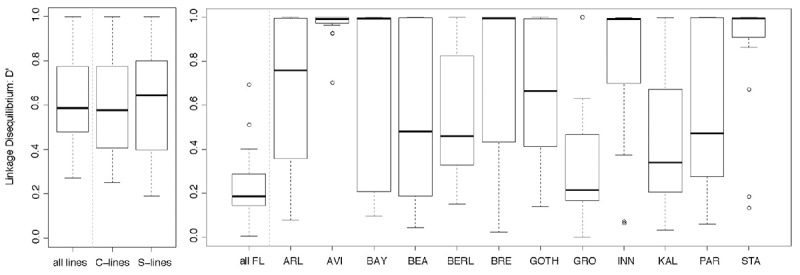
Pairwise estimates of linkage disequilibrium (D′) for six to seven SNPs in a 600 kb region on chromosome 2R. The SNPs that were genotyped are shown in Figure 1; CG4844 was not polymorphic in the Field lines and was therefore excluded from the LD analysis for the Field lines. LD was calculated for the Selection and Control lines (left panel) and for a set of 12 Field lines (right panel). The boxplots represent the distribution of all pairwise LD estimates (D′) between the six to seven SNPs for the individuals that were analyzed for individual genotype–phenotype associations. In the left panel, LD estimates were calculated for the combined Selection and Control lines (n = 144), and separately for the pooled Selection lines (n = 90) and pooled Control lines (n = 54). In the right panel, LD estimates were calculated for the combined Field lines (“all FL,” n = 400) and for each Field line separately (n = 23–52 per Field line, see Table 1 for abbreviations and sample sizes of the Field lines).